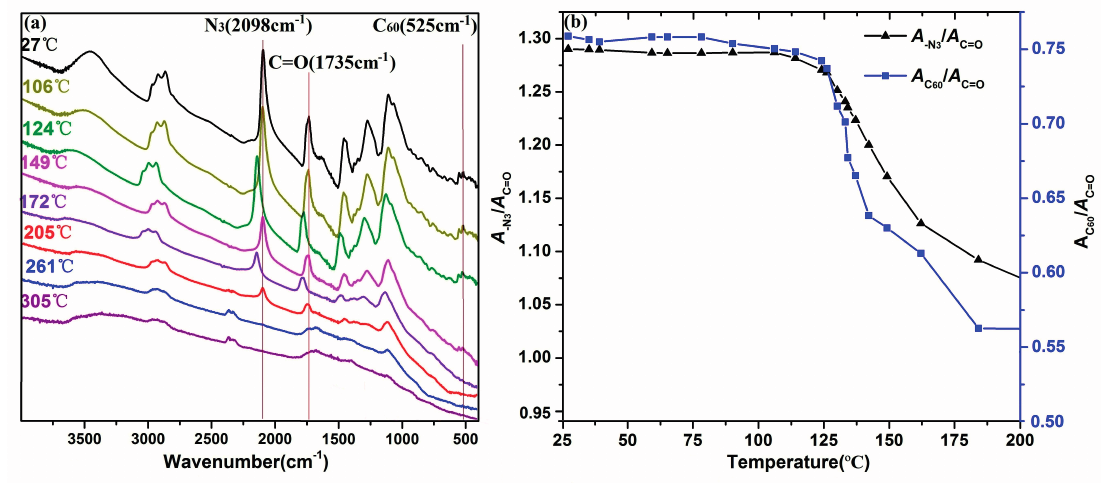
Figure 7. ( a ) FTIR spectra of C 60 -GAP decomposition condensed-phase at different temperatures under air atmosphere; ( b ) Plots of the IR absorption intensity ratio of –N 3 ( υ = 2098 cm − 1 ) and C=O ( υ = 1735 cm − 1 ), C 60 ( υ = 525 cm − 1 ) and C=O ( υ = 1735 cm − 1 ) in C 60 -GAP decomposition condensed-phase FTIR spectra at different temperatures under air